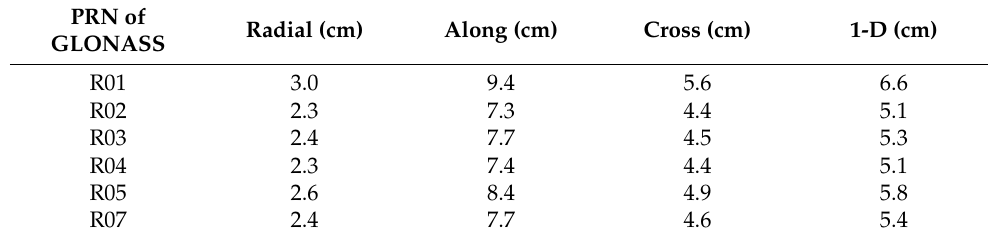
Table 6. Mean RMS value of GLONASS satellites in comparison with GFZ final